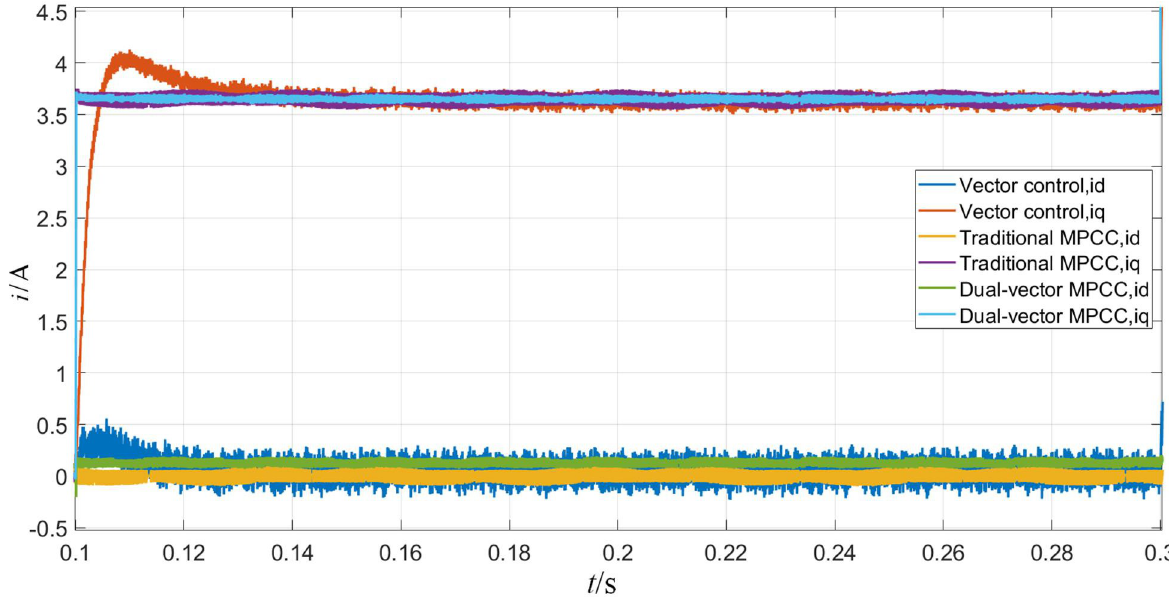
Fig 12. D-q axis current waveform when the motor is loaded with